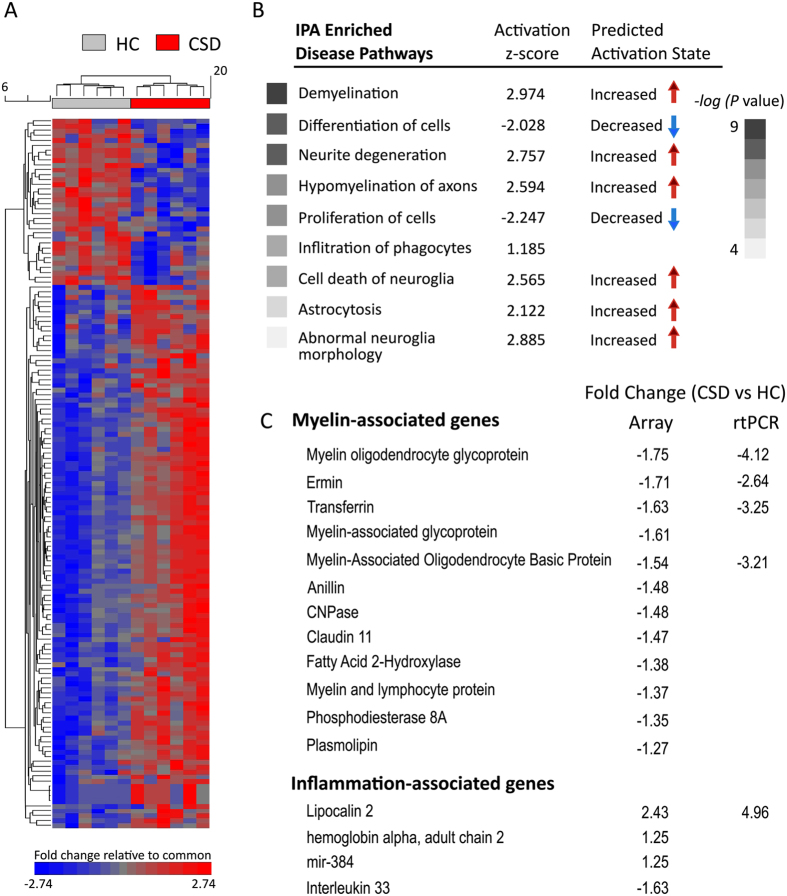
Gene expression changes induced by CSD were determined by microarray assay of the mPFC of HC vs. CSD mice.(A) Unsupervised hierarchical clustering and heatmap illustrates each individual’s expression pattern in 144 significant (p ≤ 0.05), differentially expressed named genes. Column dendrograms based on the gene expression data show that subjects cluster according to experimental conditions. Changes in gene expression are represented in the scale below the heatmap with red-to-blue gradient depicting an up- to down-regulation (≥2.74-fold increase → ≤ 2.74-fold decrease). (B) Highly enriched disease pathways was determined by Ingenuity Pathway Analysis (IPA) for all significantly altered gene transcripts. The z-score reported in the analysis describes the uniformity of the predicted activation state of the disease pathway with regard to what the change in gene expression was for the overlapping genes included in that pathway. (C) Selected myelin-associated genes and inflammation-associated genes are ranked by fold change. The direction and magnitude of changes were confirmed by qRT-PCR for a selected subset of up and down-regulated genes.